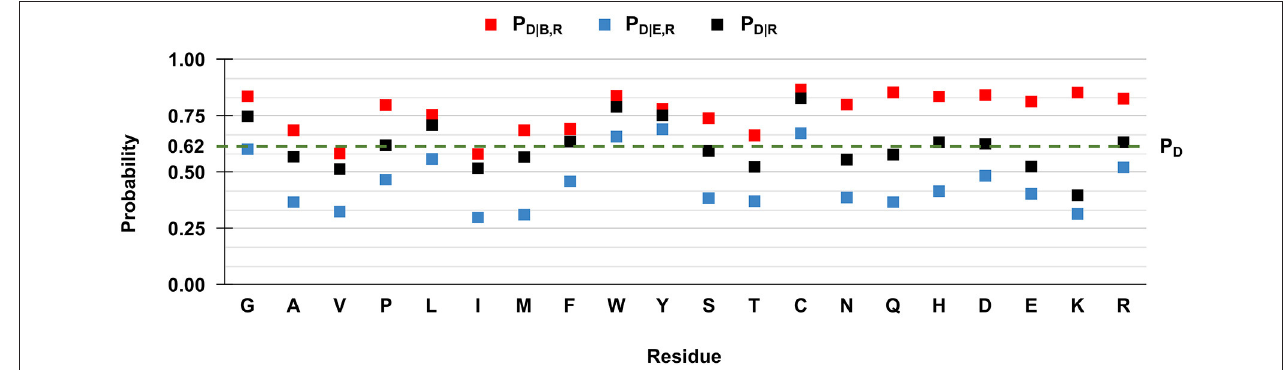
FIGURE 3 | Probabilities of the 20 wild-type residues undergoing disease-related variations, depending on the wild type residue and the exposure state in HVAR3D-2.0. Buried and exposure state of each residue position are estimated with DSSP as described in Section: Analyzing distributions of variated wild-type residues in the structure database. P D : the probability of a wild-type residue (position) to be disease associated in the HVAR3D-2.0 dataset [see Equation (1)]. P D | R : the conditional probability of being disease related when variated, given a wild-type residue [see Equation (2)]. P D | B , R : the conditional probability of a wild-type residue to be disease related upon variation when buried [see Equation (3)]. P D | E , R : the conditional probability of a wild-type residue to be disease related upon variation when exposed [see Equation